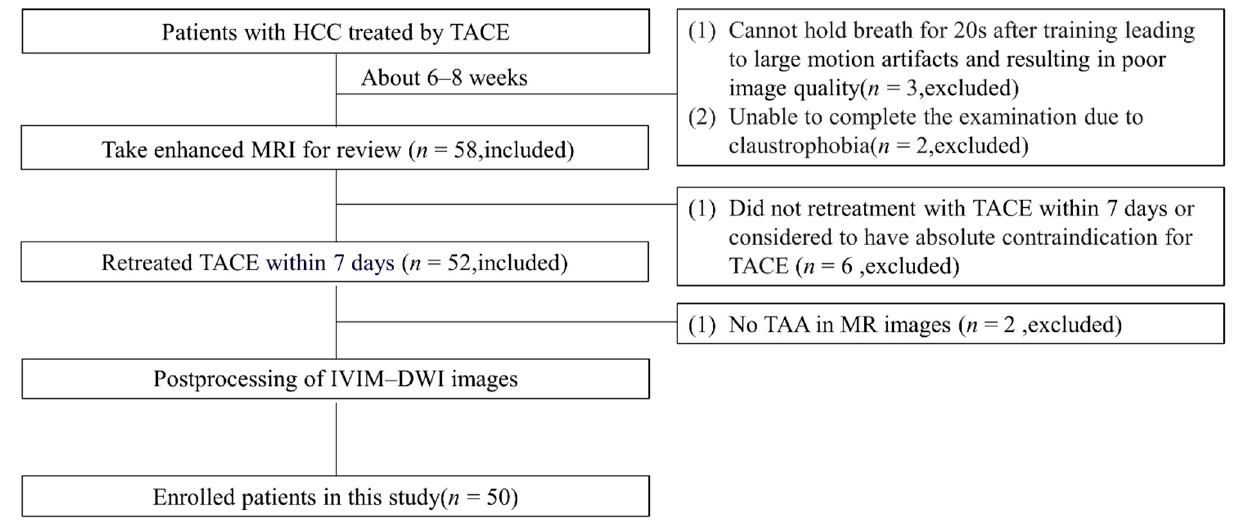
Figure Figure 1. The flowchart shows the inclusion and exclusion process of the study patients. HCC: hepa ‐ tocellular carcinoma; TACE: transarterial chemoembolization; TAA: tumor active area.